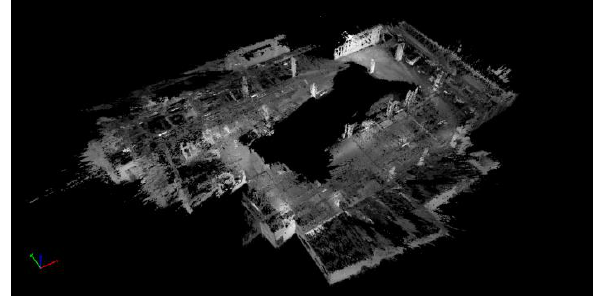
Figure 4. Entire 3D map of the underground garage